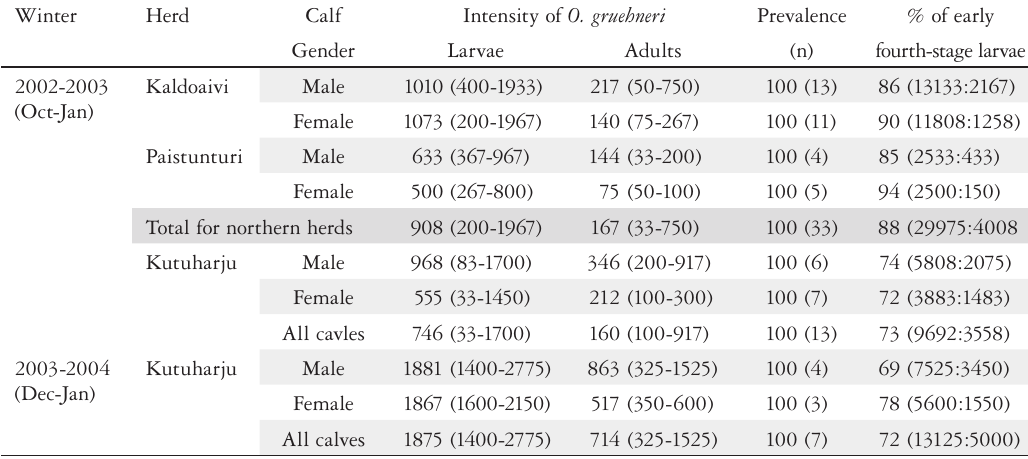
Table 2. Infection of Ostertagia gruehneri in reindeer calves. Mean intensity (range in parenthesis), prevalence (% infected), and percentage of nematodes found in the early fourth-stage of larval development (number of larvae and adults in parenthesis) of the abomasum (liquid contents and digested mucosa).